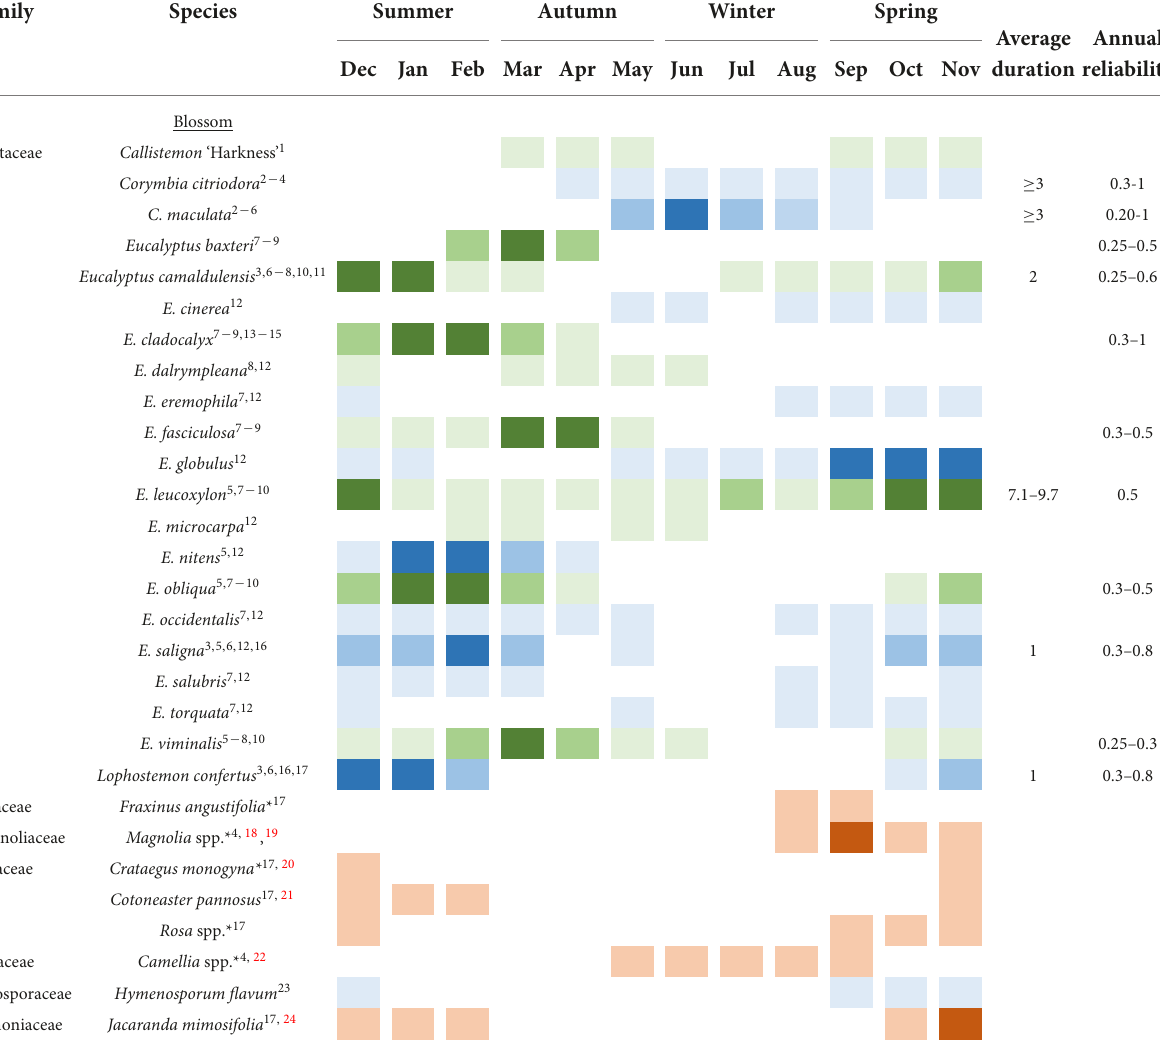
TABLE 1 The flowering phenology of the food plant species visited by ( n = 9) GPS tracked Pteropus poliocephalus in the Adelaide region between Dec 2019 and May 2020. Family Species